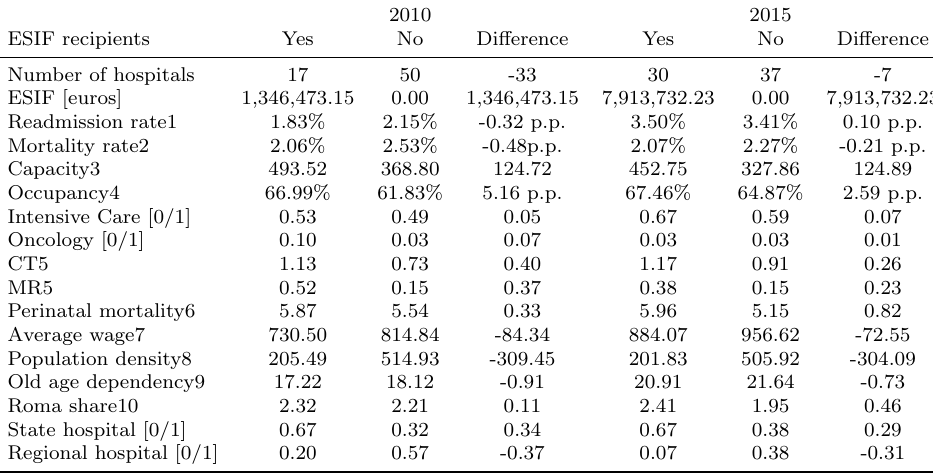
Table 1: Comparison of mean values of variables between ESIF recipients and other